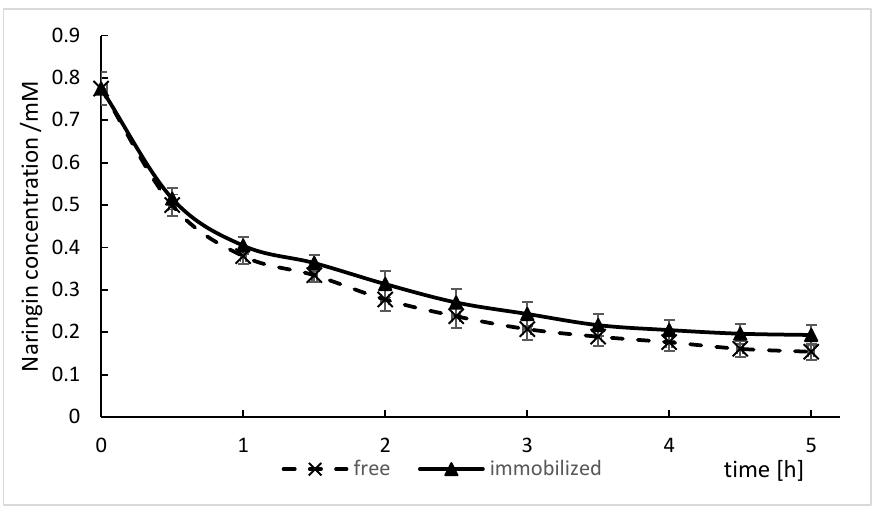
Figure 7. Hydrolysis of naringin from grapefruit juice as a function of time.